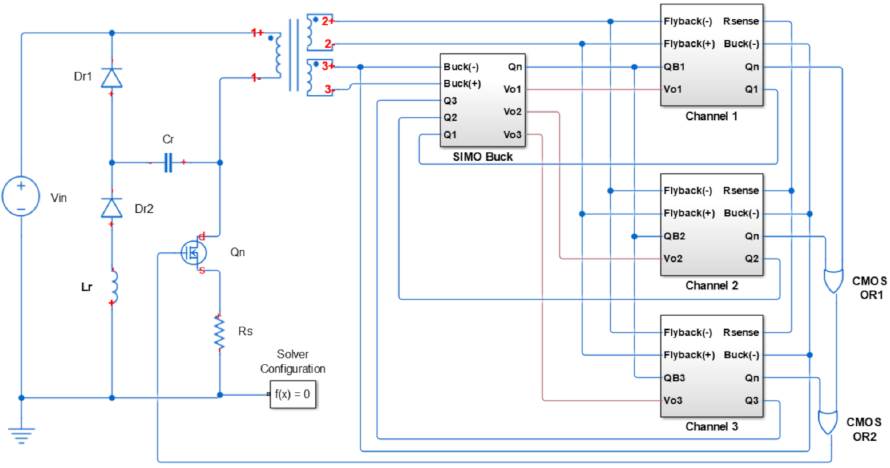
Figure 14. Block diagram of the proposed converter as a three-channel power